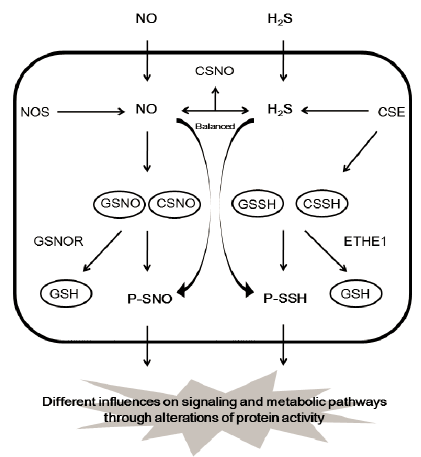
Figure 5. The pool of donors for protein S-nitrosylation and S -sulfhydration. ETHE1, mitochondrial persulfidedioxygenase; GSNOR, GSNO reductase.